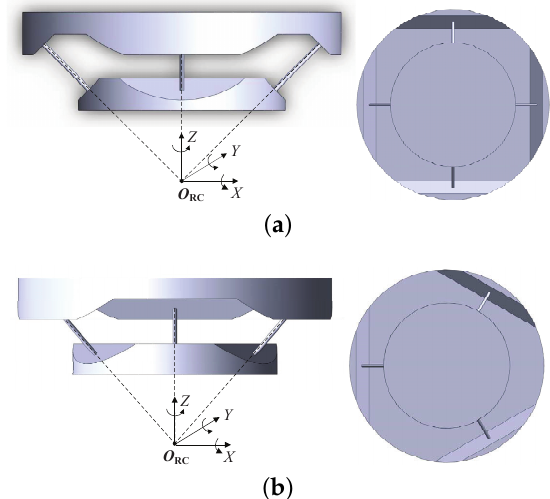
Figure 2. Two kinds of remote center compliance (RCC) mechanism. ( a ) The RCC mechanism with four-beam flexures; ( b ) The RCC mechanism with triple-beam flexures.